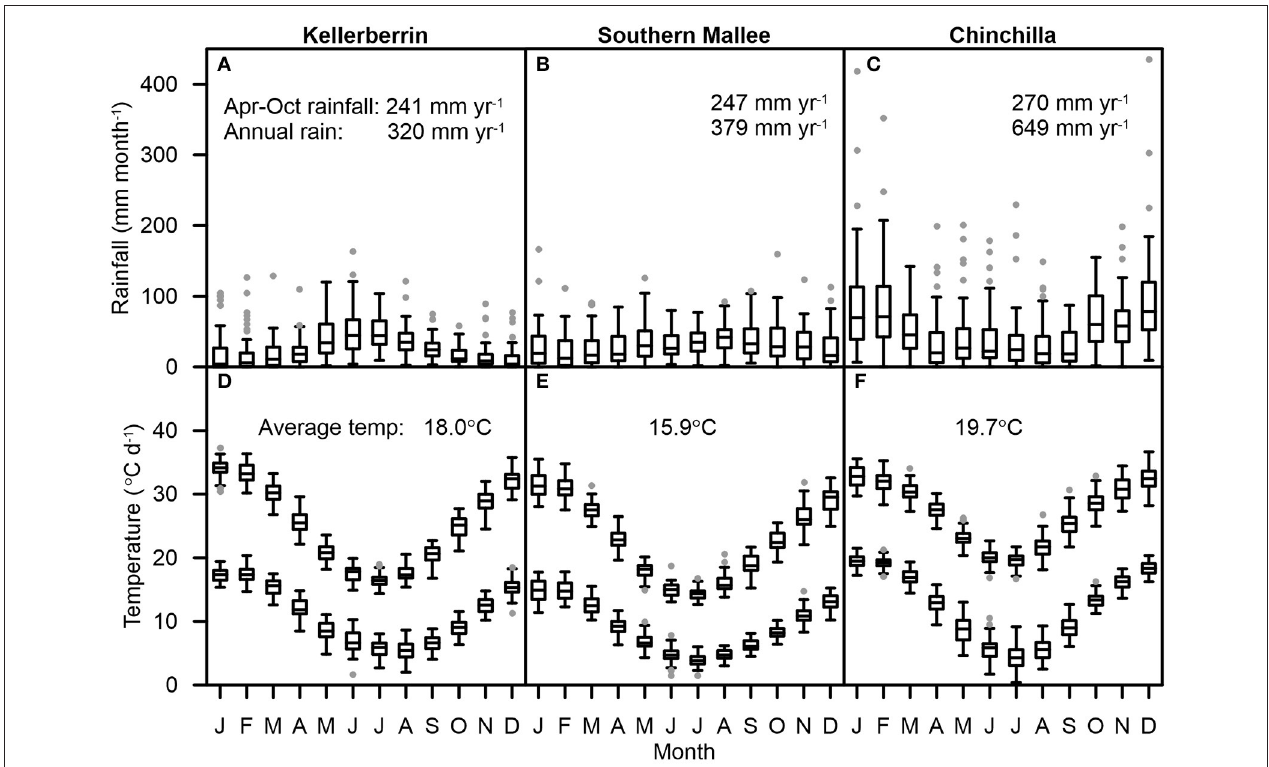
FIGURE 1 | Monthly rainfall (A–C) and minimum and maximum daily temperature (D–F) for the period 1954–2013 recorded in the climate files used to simulate the Kellerberrin, Southern Mallee, and Chinchilla case study farms. Plots show the median, 25 and 75th percentiles in the box, with 1.5 times the interquartile range in the whiskers and outliers shown as